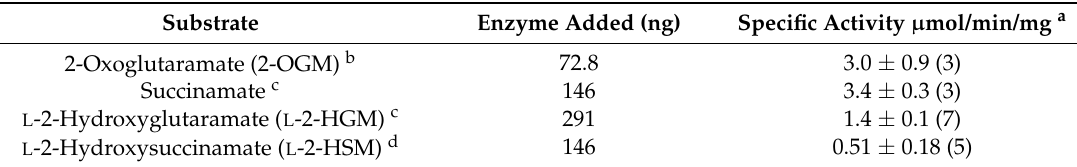
Table 1. Substrates of human Nit 2/ ω